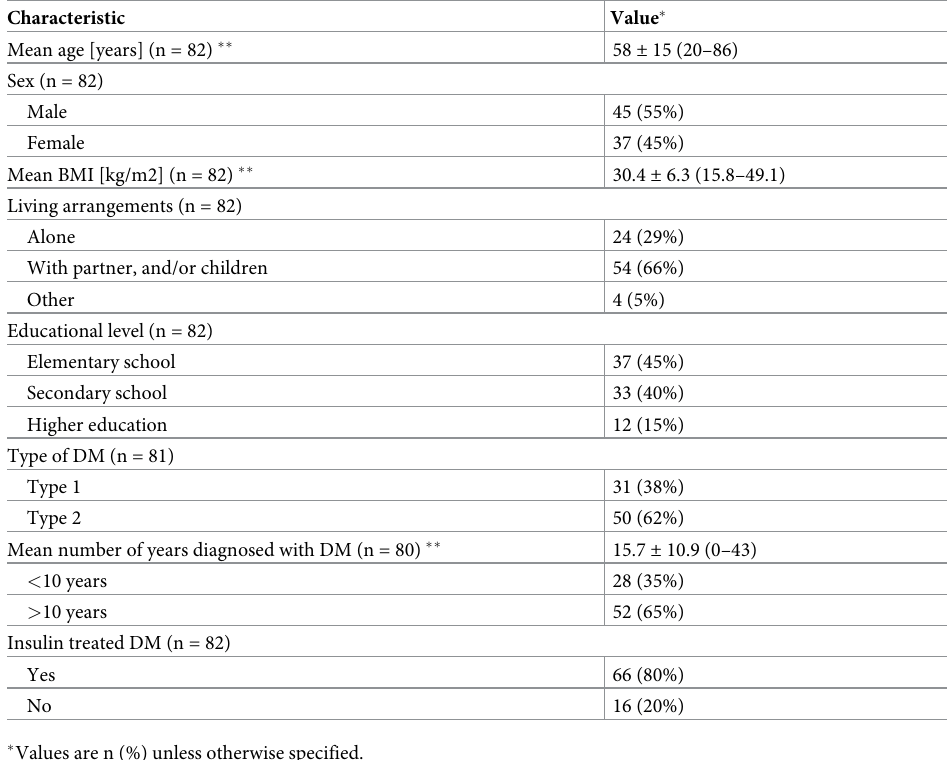
Table 1. Demographic